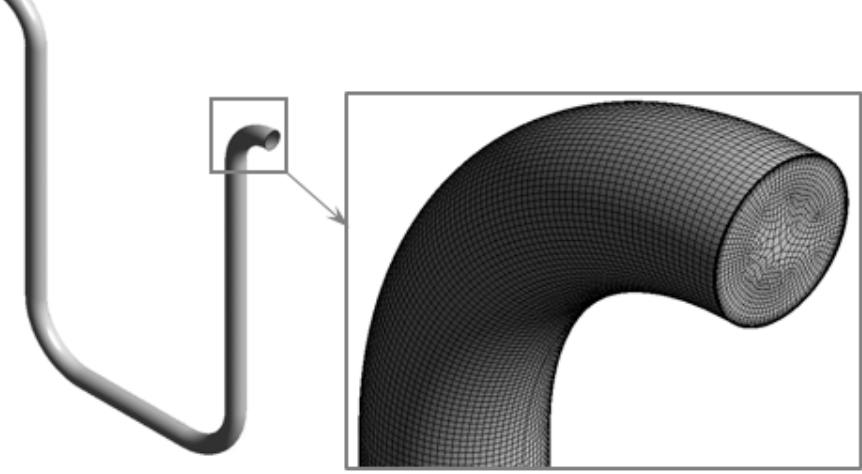
Figure 5. Typical space discretization for the computational simulation.